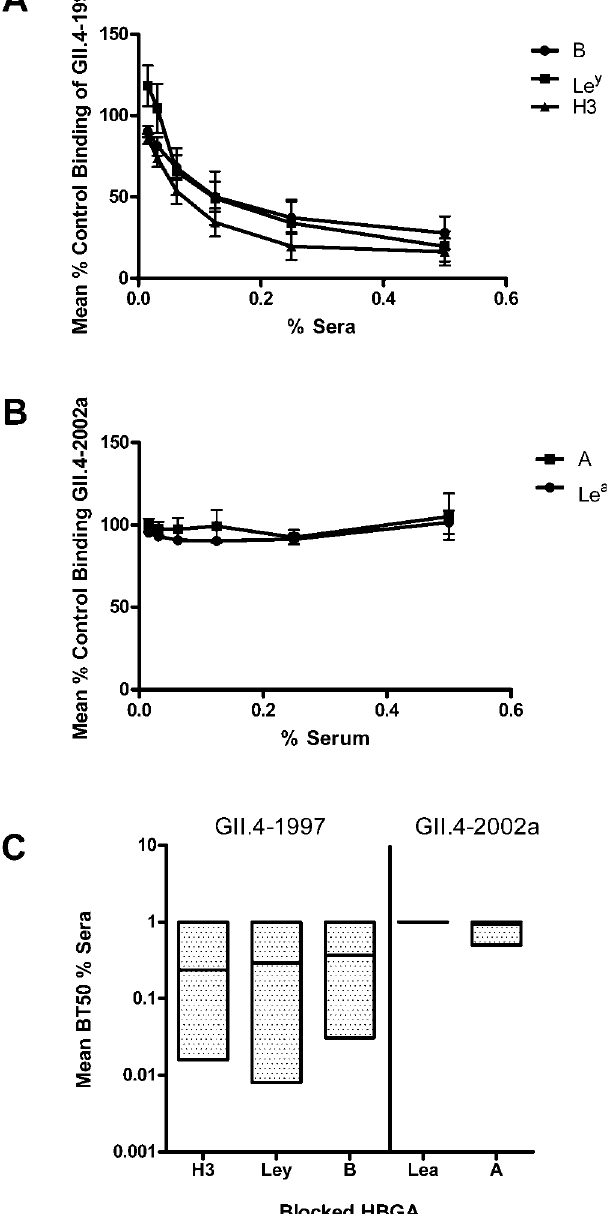
Figure 10. Blockade of Alternative HBGA Ligands by Outbreak Sera Convalescent serum samples collected from a GII.4 outbreak in 1988 were assayed for blockade of GII.4–1997-H type 3, Le y , and B-antigen trimer interaction (A) as well as GII.4–2002a-Le a and A-antigen trimer interaction (B) and the mean percentage of control binding calculated compared to the no-serum control binding. Error bars represent standard error of the mean. The floating bar plot (C) shows the mean percentage of sera needed for BT50 for each VLP and alternative HBGA ligand. The mean titer is indicated by the line in the box. The upper and lower boundaries of the box represent the maximum and minimum